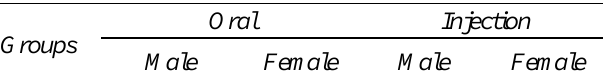
intraperitoneal injection treatment of rats with SlNPV, AcMNPV or AcAaIT.